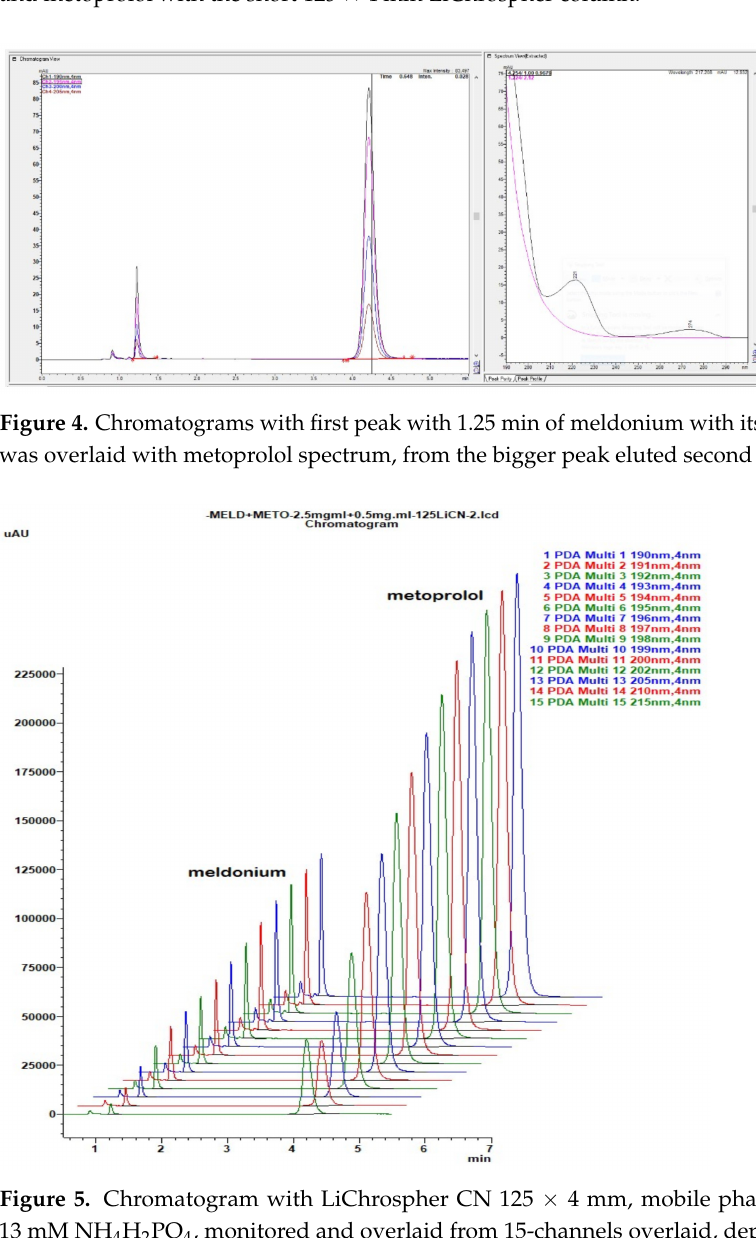
Figure 3. Overlaid chromatograms for linearity of peak responses to concentrations for meldonium and metoprolol with the short 125 × 4 mm LiChrospher column.